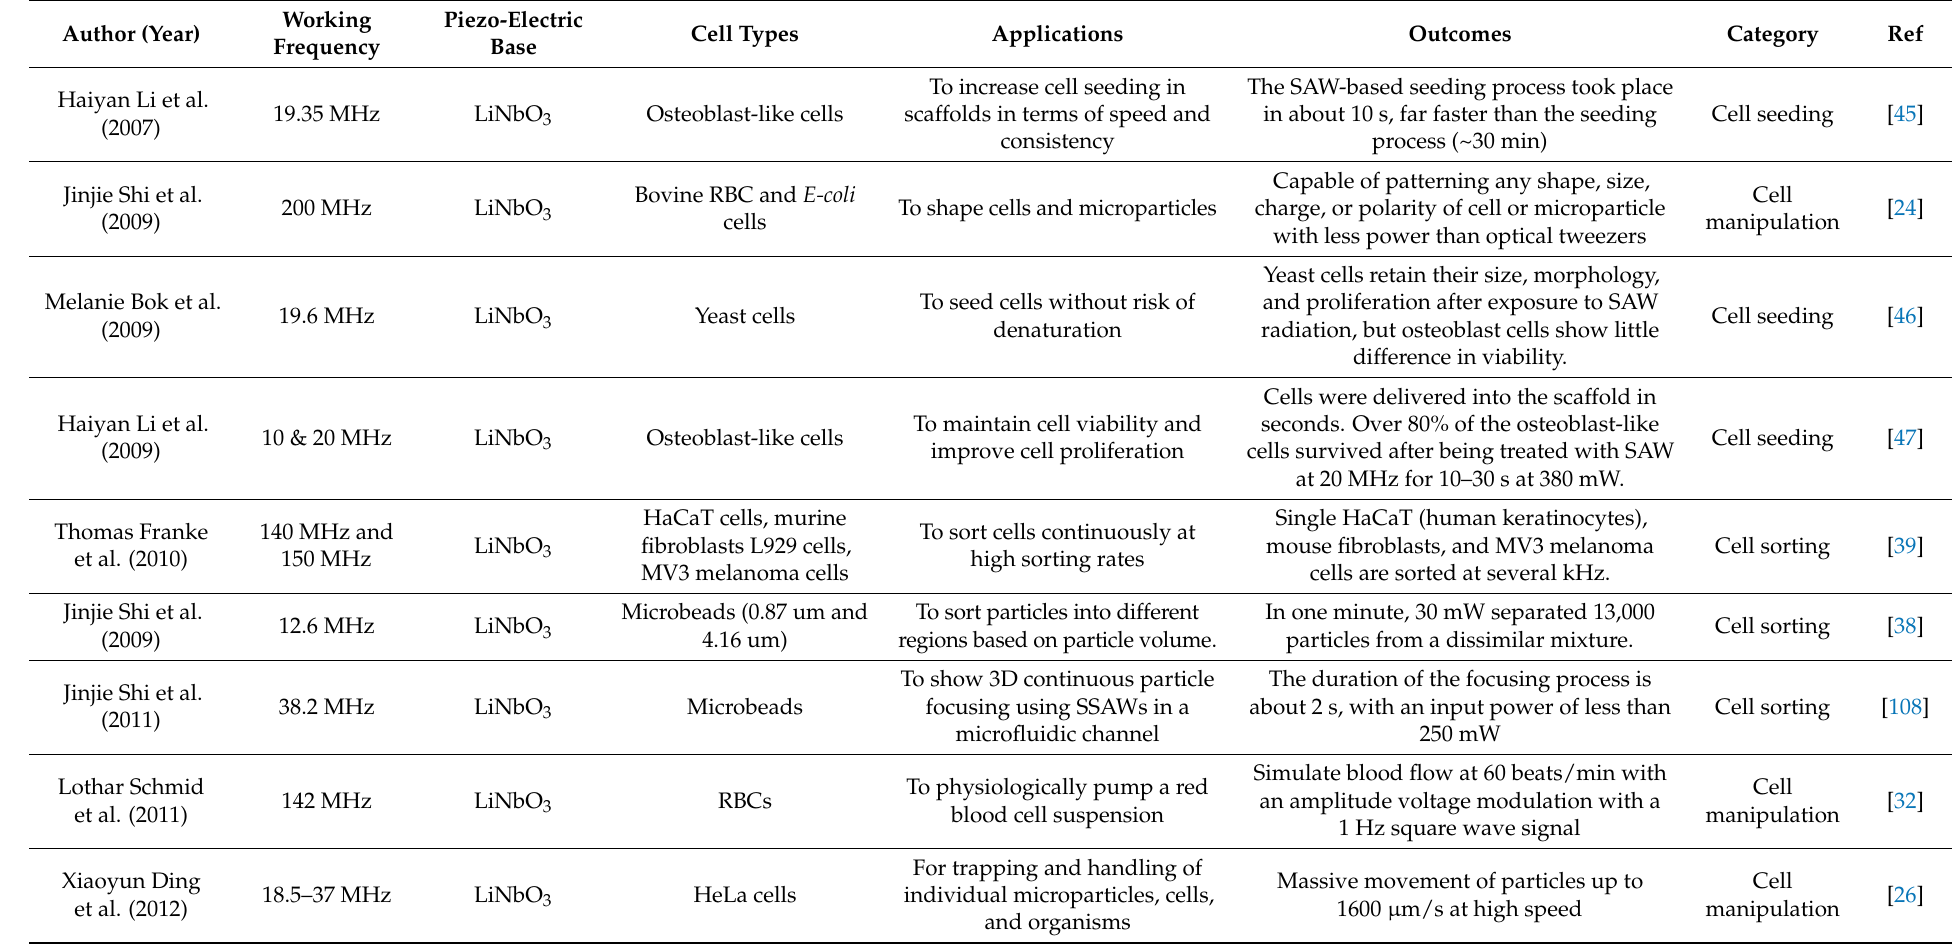
Table 2. Summary of the various applications of IDT-based SAW device on cell